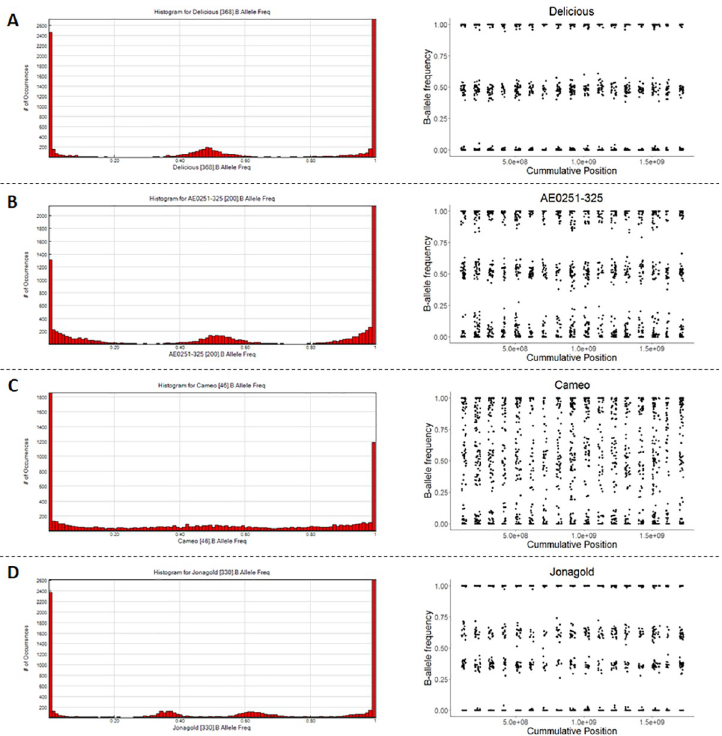
Fig 2. Histograms of B-allele frequency (left) and B-allele frequency for each SNP plotted against its genomic position (right). Such histograms were used to assess a sample’s genotyping quality and ploidy. Examples shown are of a sample with good quality genotype calls (panel A), with intermediate quality of genotype calls (B), with bad quality of genotype calls (C), and that is triploid